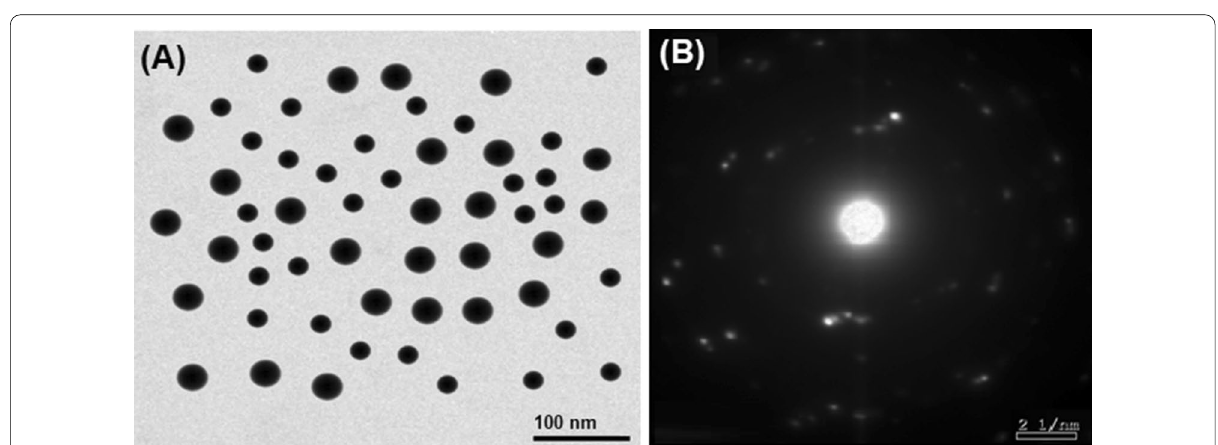
Fig. 2 TEM analysis of ZnONPs synthesized by the fungus A. tenuissima ; ( A ) TEM micrograph and ( B ) SAED pattern